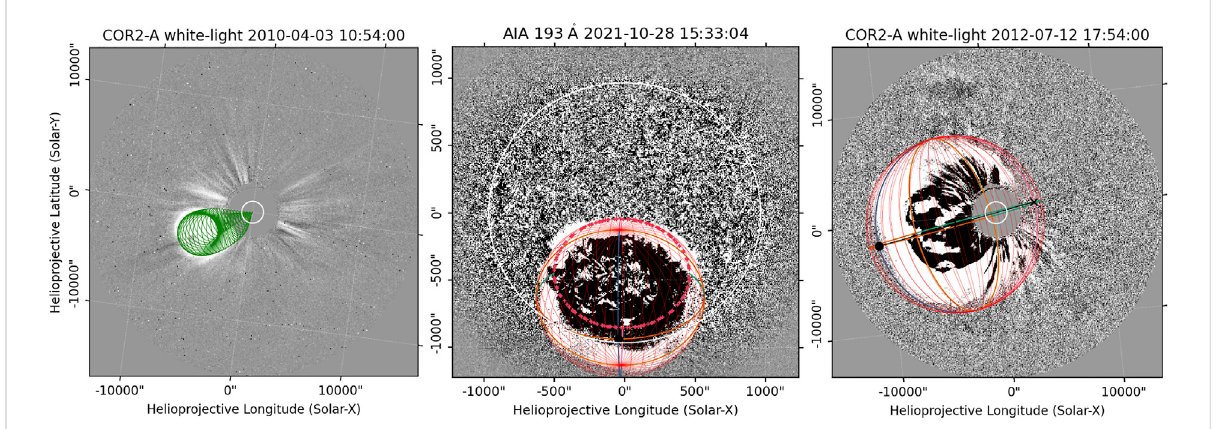
FIGURE 2 Running difference images in WL (right and left panels) and EUV (middle panel) produced with PyThea. The GCS (green grid), ellipsoid and spheroid models (red grid) are overplotted to the